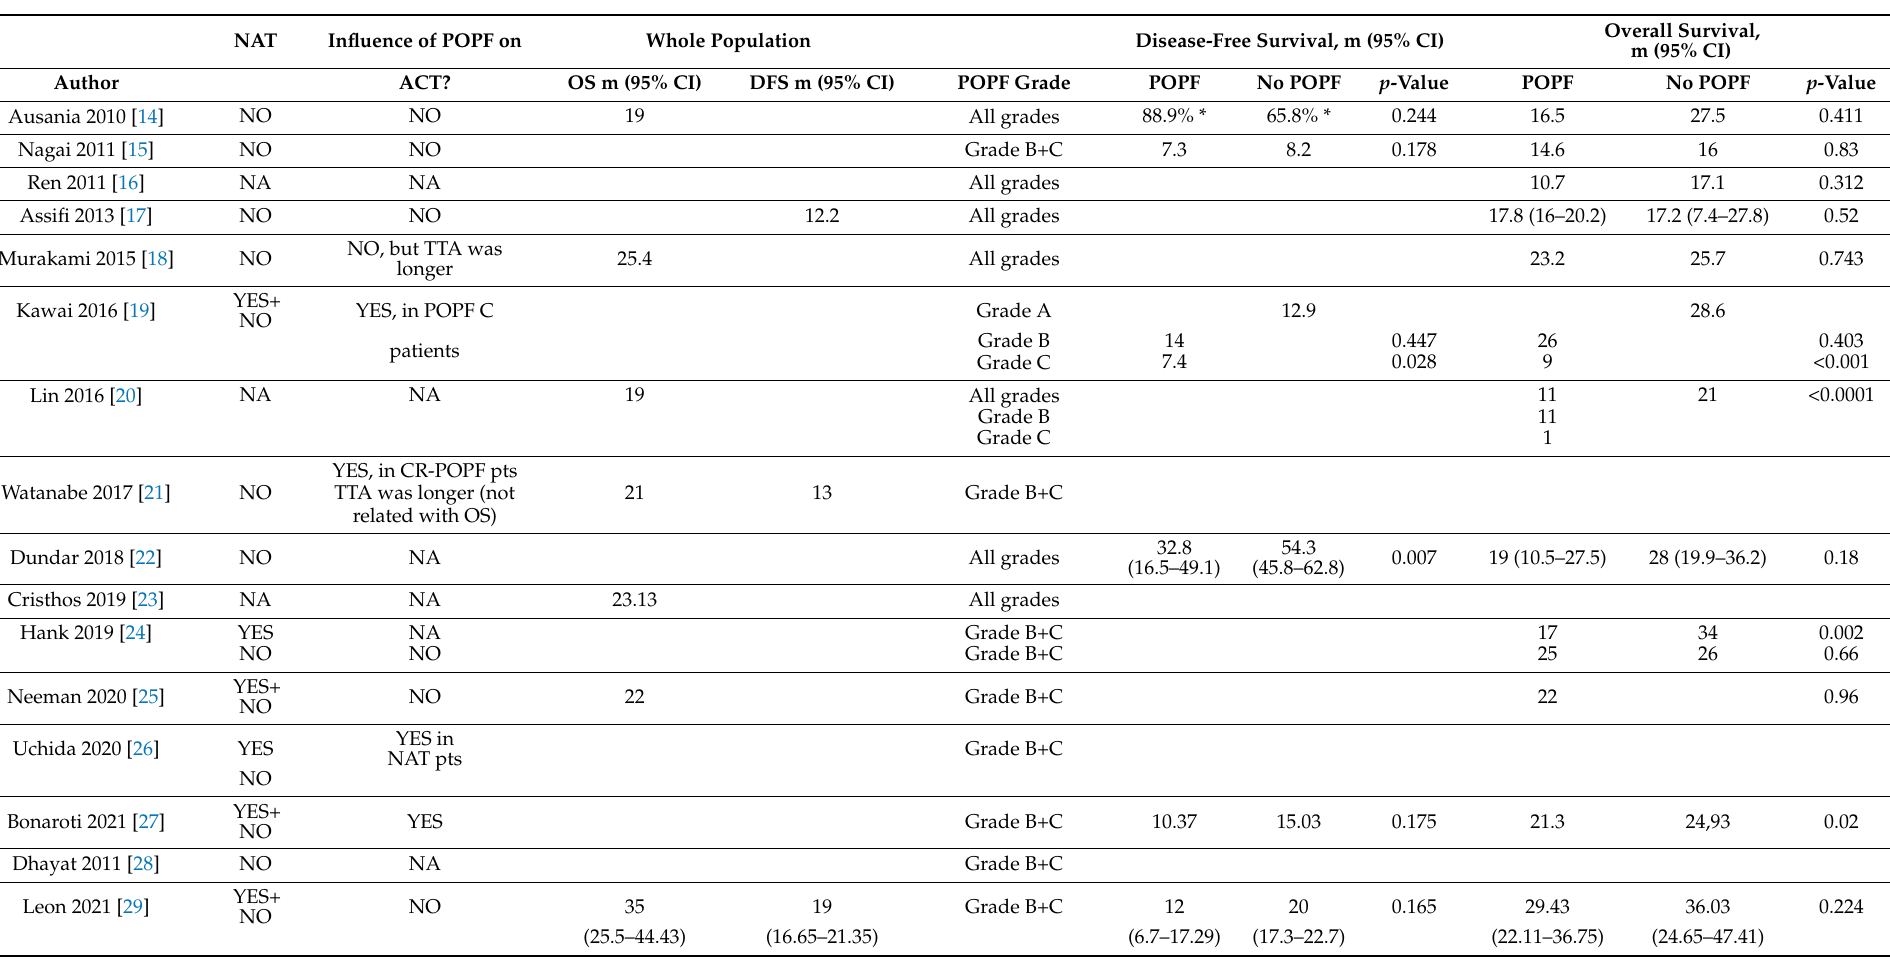
Table 2. Neoadjuvant therapy, modified adjuvant chemotherapy, disease-free survival, and overall survival in patients with and without postoperative pancreatic